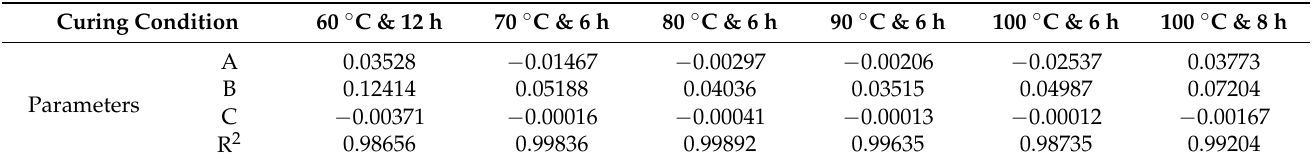
Table 7. Parameters of ∆ h quadratic polynomial